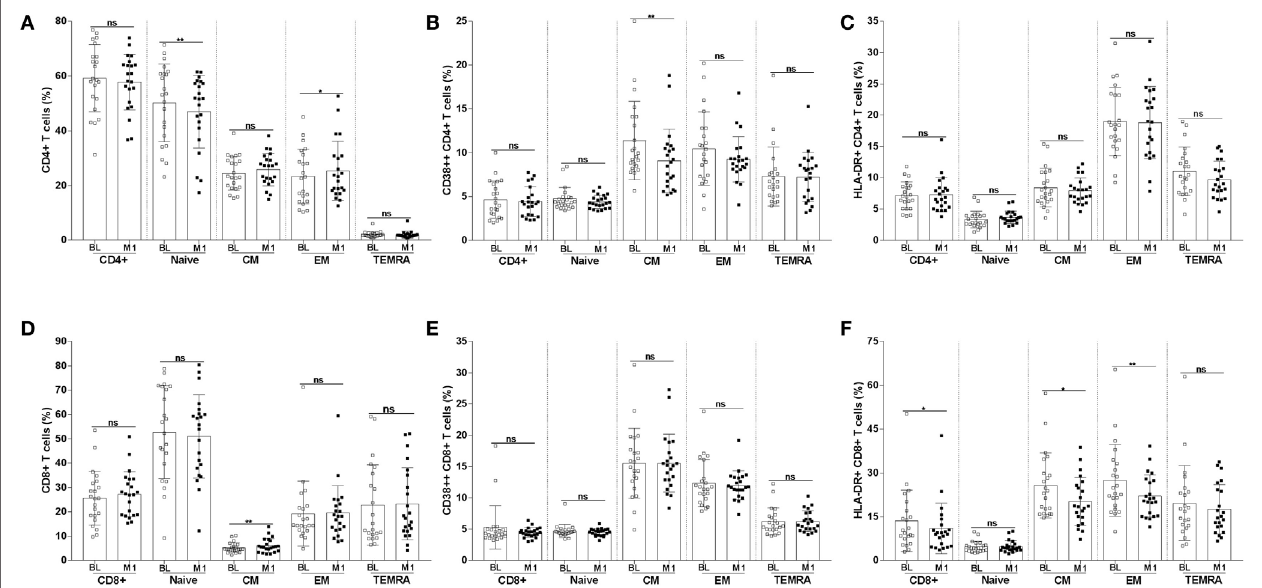
FigUre 3 | Frequency of CD4 + and CD8 + T-cell subpopulations and of T cells expressing the CD38 and HLA-DR activation markers. CD4 + T cells were divided into naïve, CM, EM, and TEMRA. The frequencies of CD4 + T-cell subpopulations (a) were assessed at BL and 1 month postvaccination. The frequency of CD4 + T-cell subpopulations expressing CD38 (B) and HLA-DR (c) were also measured. The frequency of CD8 + T-cell subpopulations and of CD8 + T cells expressing CD38 and HLA-DR are shown in panels (D–F) . * p < 0.05; ** p < 0.01; ns, not significant; BL, baseline; M1, month